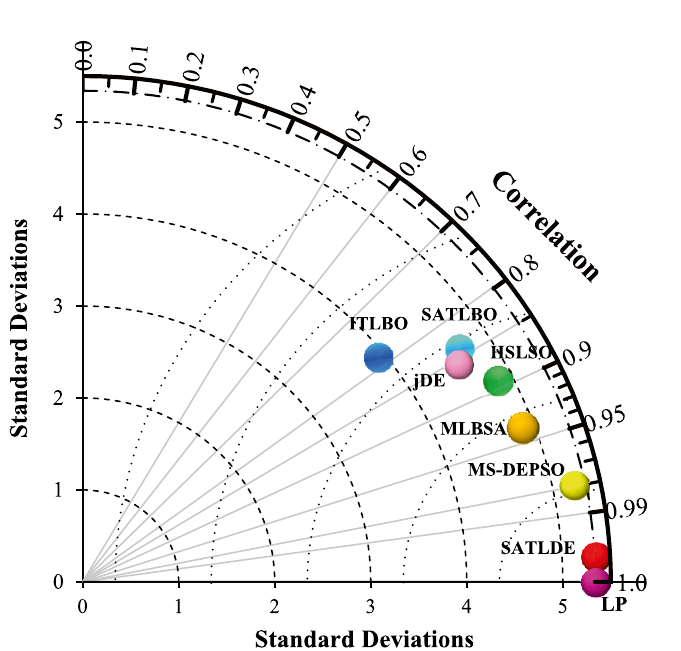
Figure 10. Taylor diagram of all optimizers for ten-reservoir